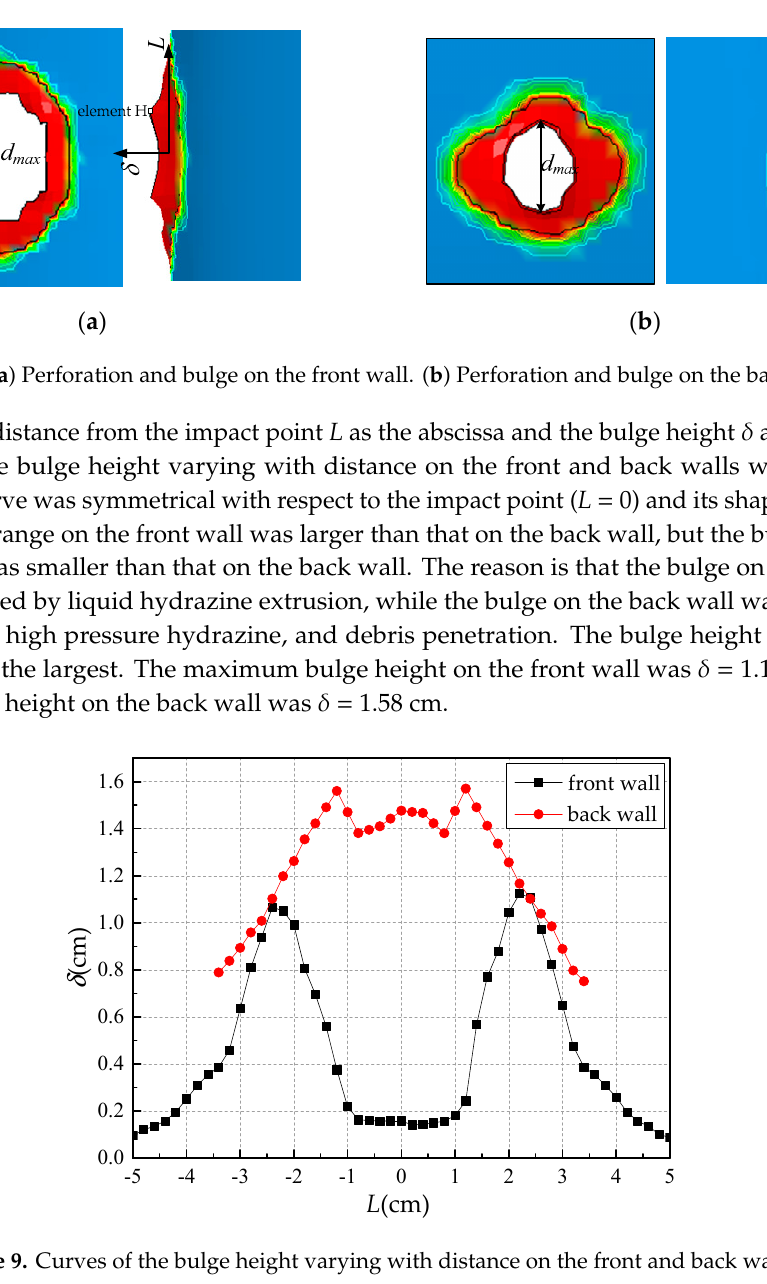
Figure 9. Curves of the bulge height varying with distance on the front and back walls.